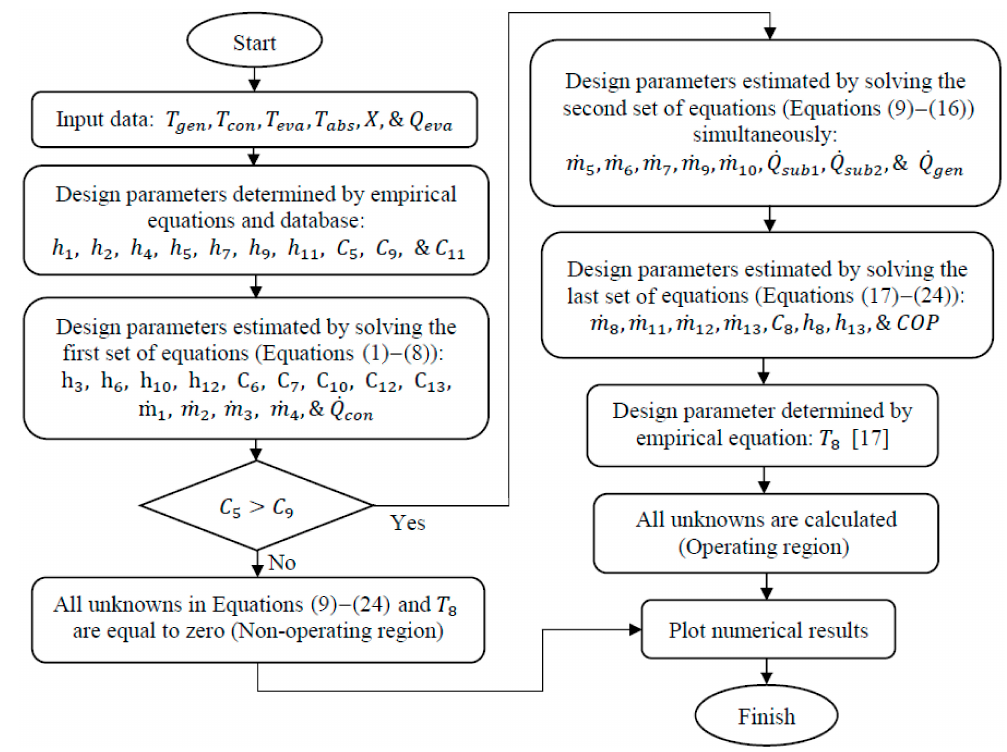
Figure 2. Program flowchart of an LiBr/water absorption refrigeration system equipped with an adiabatic absorber.